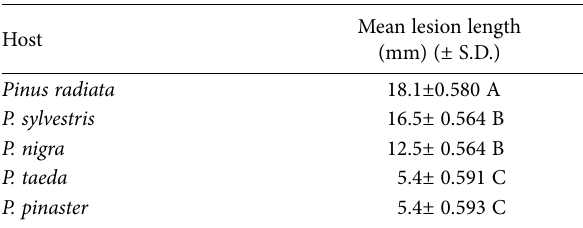
Table 8. Mean lesion lengths caused by Diplodia sapinea on seed- lings of different Pinus spp.